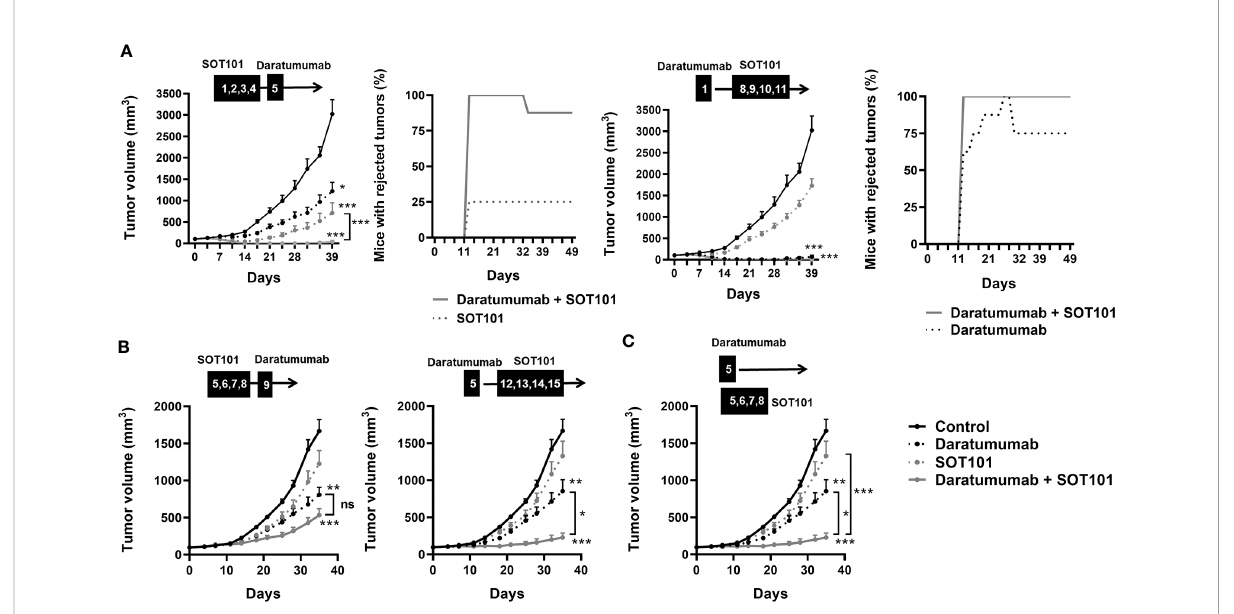
FIGURE 5 SOT101 potentiates the therapeutic activity of Daratumumab in a solid human multiple myeloma xenograft model in vivo in dependence on the combination schedule. SOT101 was administered SC at 1 mg/kg and Daratumumab was administered IP at 20 mg/kg at the indicated timepoints (A) sequential drug schedules in the early therapeutic setting where treatment started at randomization day 1 (~ 100 mm 3 ). (B) sequential drug schedules in the late therapeutic setting where the treatment started 4 days post randomization (day 5) (C) . Concomitant drug schedule in the late therapeutic setting. Data are presented as mean ± SEM from 8 mice and show a representative study of n = 2. The results were considered statistically signi fi cant if * p < 0.05, ** p < 0.01 or *** p < 0.001; ns, not signi fi